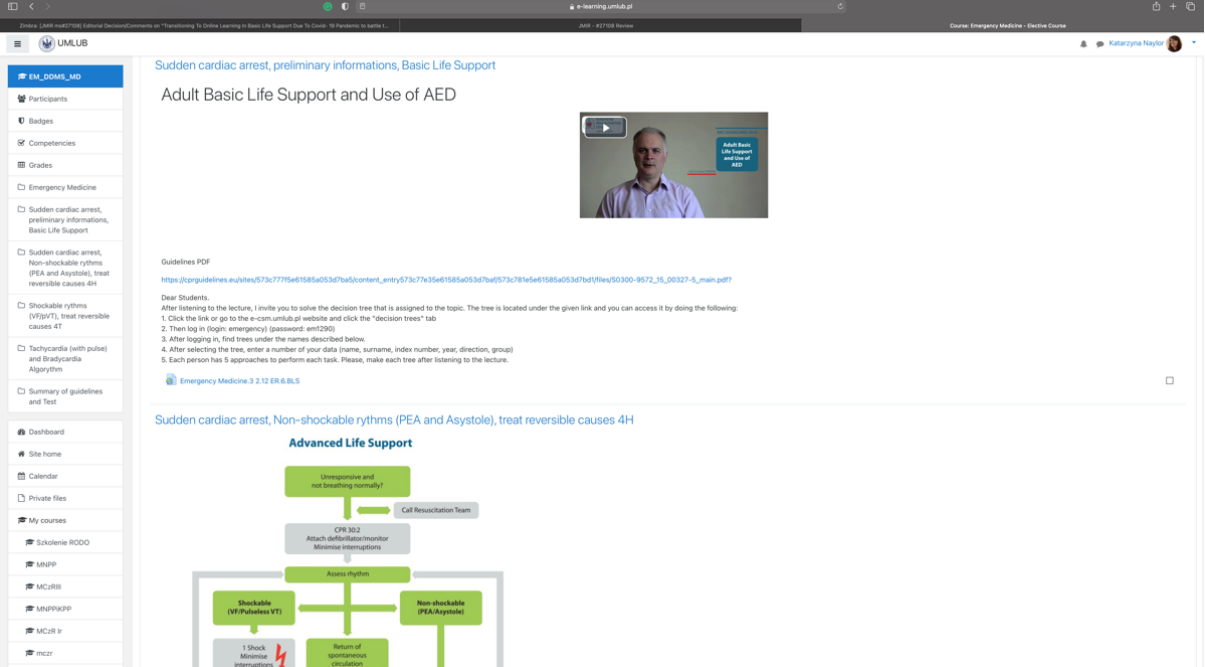
Figure 3. A screenshot of another course on Moodle and a decision tree for instruction. AED: automated external defibrillator; PEA: pulseless electrical activity; VF: ventricular fibrillation; VT: ventricular